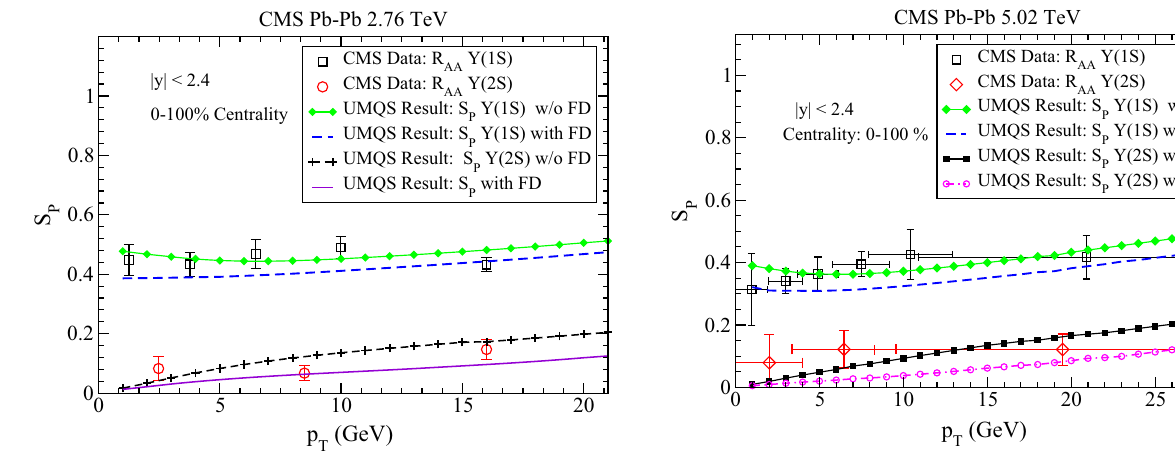
AA [90] in Pb–Pb collisions at √